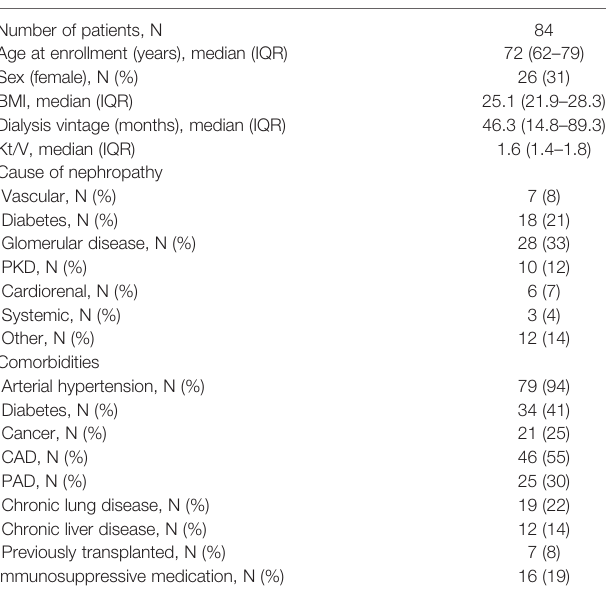
TABLE 1 | Baseline